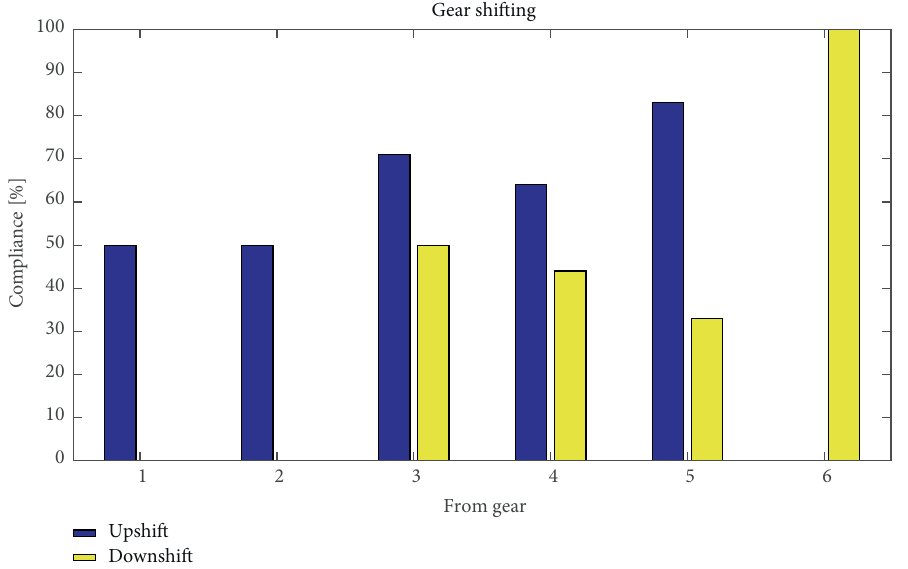
Figure 11: Estimated gear shift compliance from the field